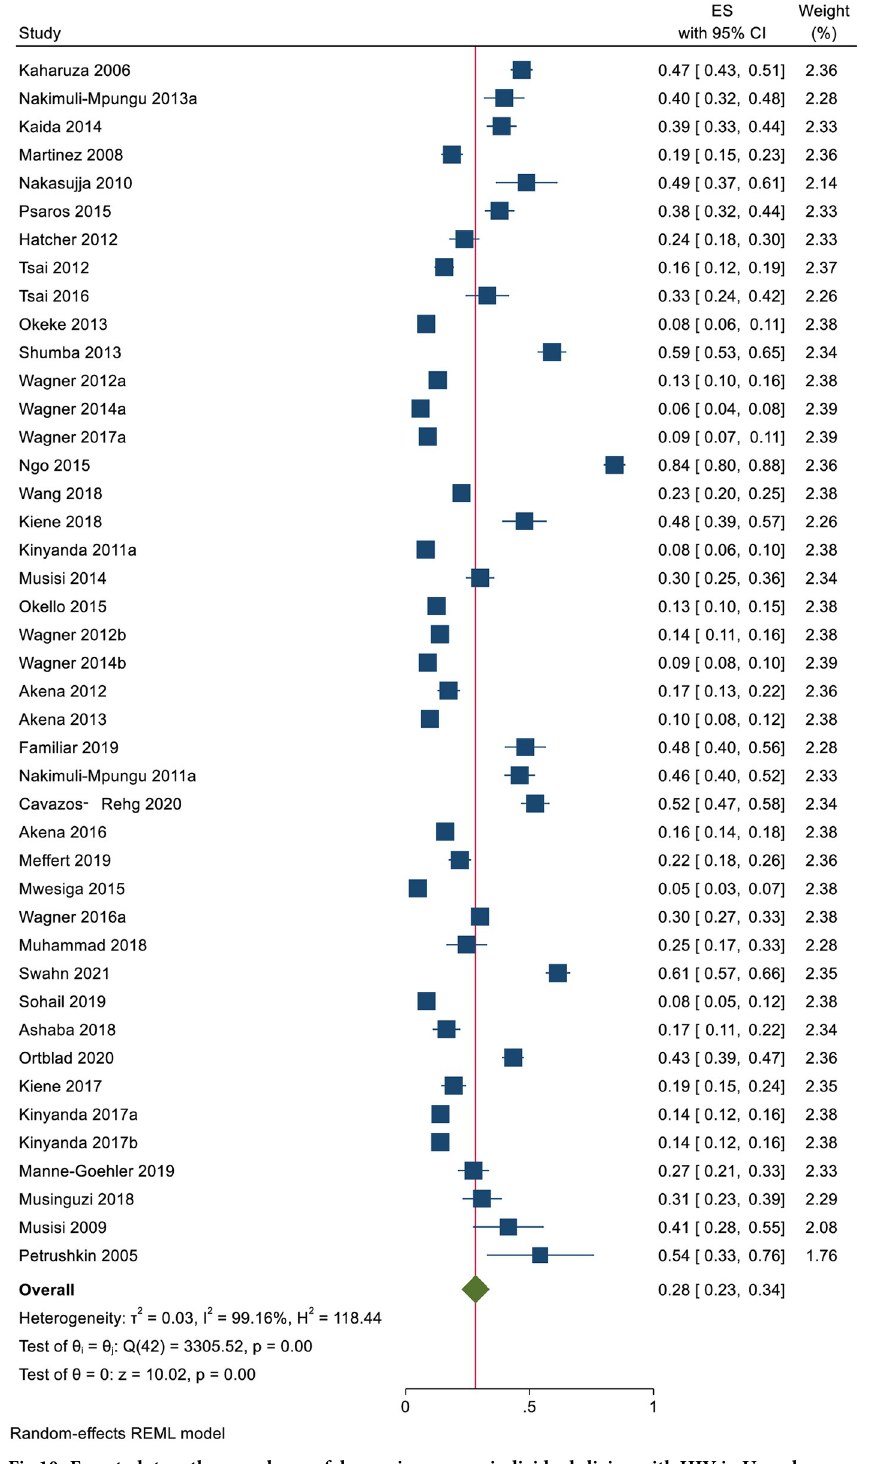
PLOS ONE | https://doi.org/10.1371/journal.pone.0276552 October 20,